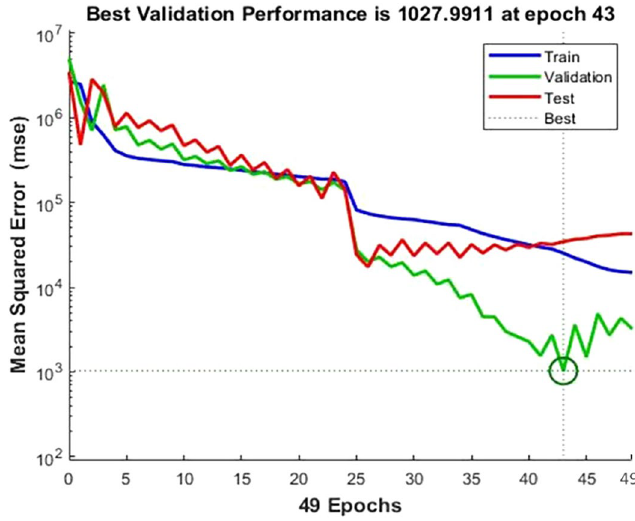
Figure 4. Mean squared error (MSE) of cherry coffee validation